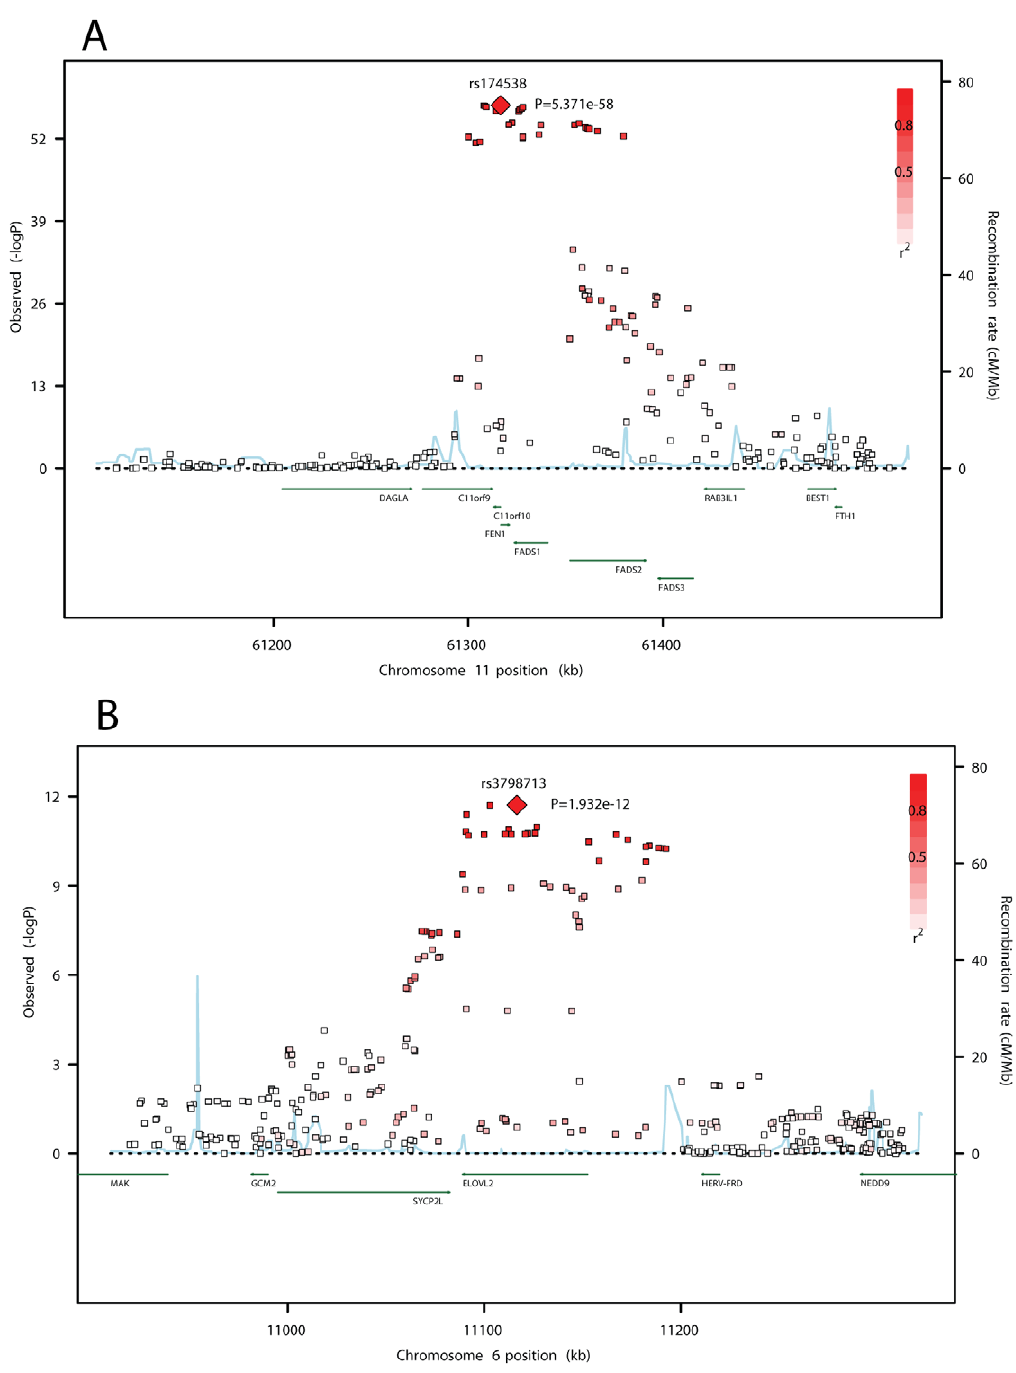
Figure 3. SNP association plots for EPA–associated regions. Genome-wide association significance level is plotted against the y-axis as –log 10 (p-value). Genetic coordinates are as per NCI build 36. A) FADS cluster region. LD is indicated by color scale in relationship to marker rs174538. B) ELOVL2 region. LD is indicated by color scale in relationship to marker rs3798713. The color scheme is red for strong linkage disequilibrium (LD; r 2 $ 0.8) and fading color for lower